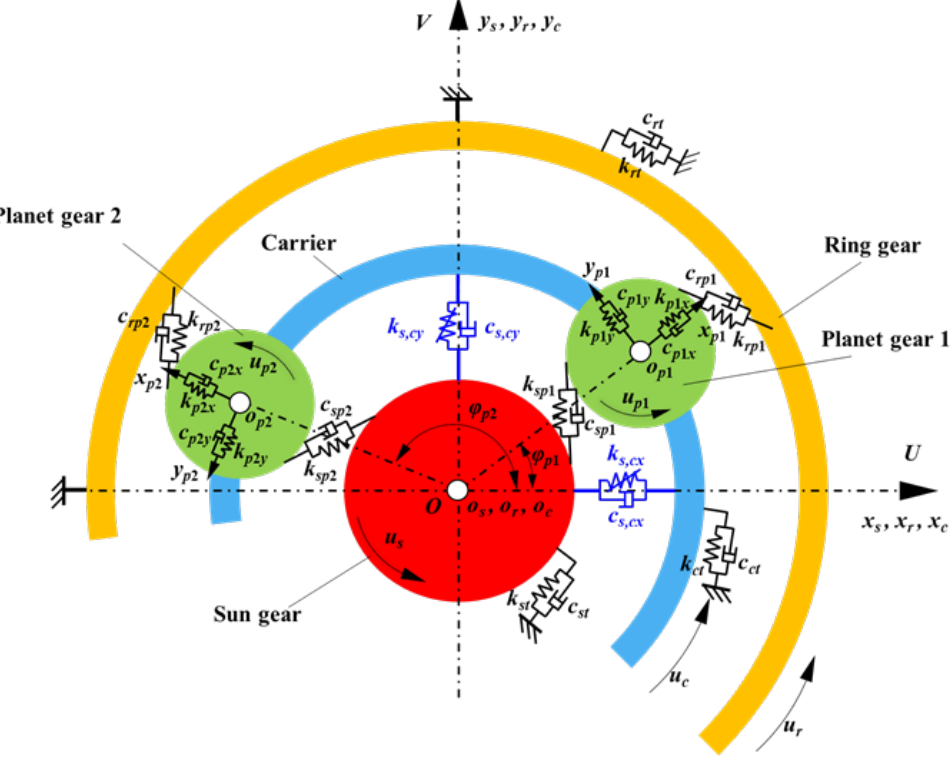
Figure 3. Lumped parameter model of the PGS .